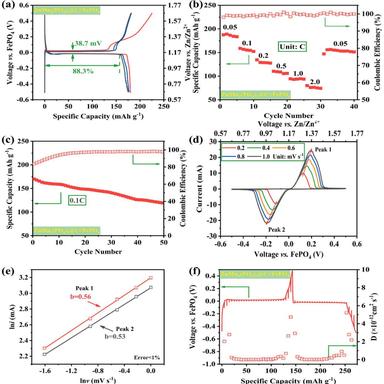
ZnMn2(PO4)2 @C//FePO4 nonaqueous ZIBs system: (a) The first three cycle profiles; (b) the rate performance; (c) the cycle performance; (d) CV curves at different scan rates; (e) plots of lni vs. lnv calculated from CV curves and their fitting lines; (f) GITT curves and calculated Zn2+ diffusion coefficient.